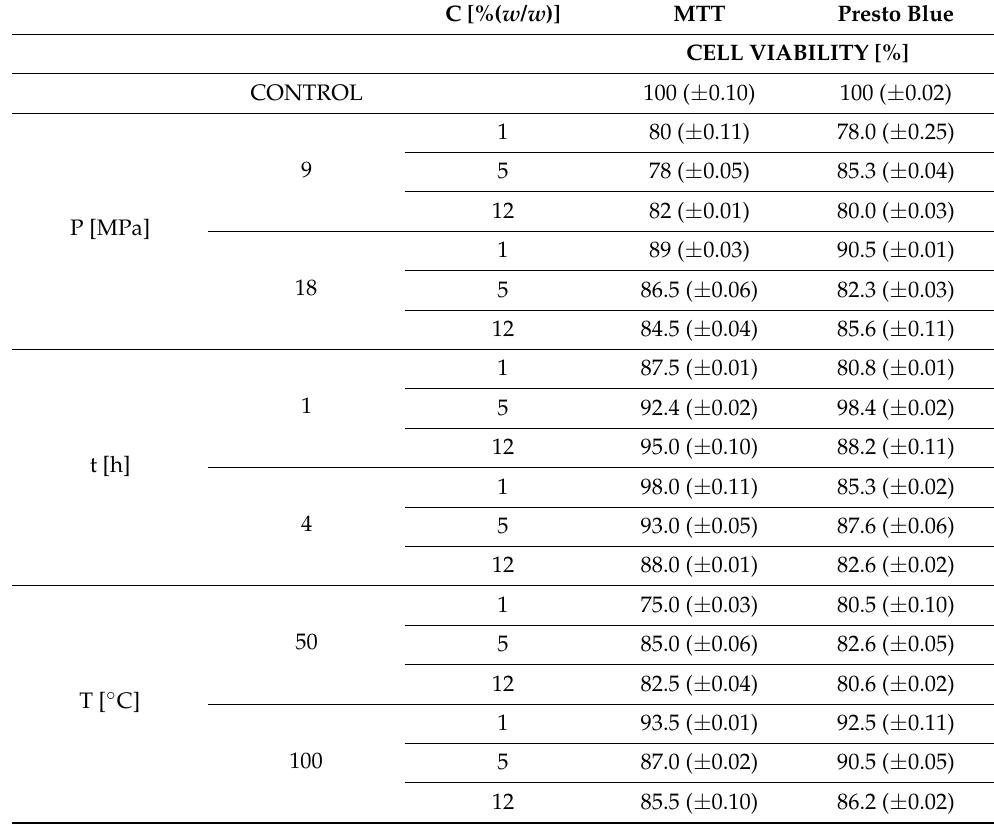
Table 3. Influence of the concentration of the applied additive nHA and the foaming process conditions: pressure P sat , temperature T sat , saturation time t sat on the viability of